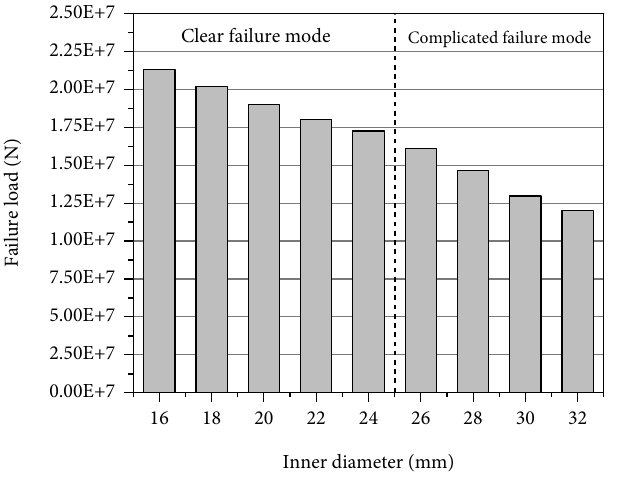
Figure 10: Failure load of shear pins with di ff erent inner diameters.